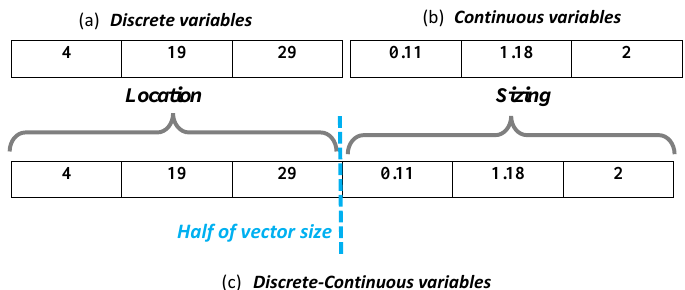
Figure 1. Discrete–continuous